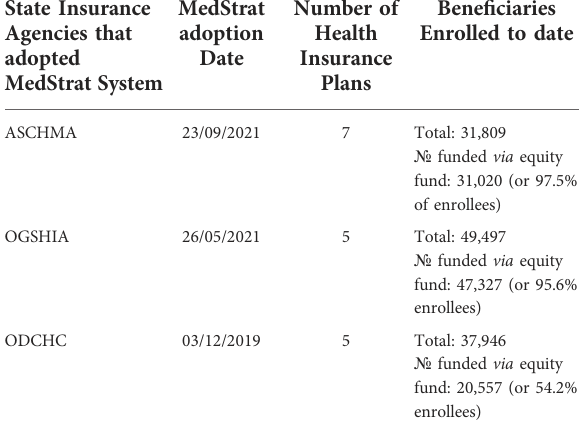
TABLE 1 State client, bene fi ciary, and provider enrollment into MedStrat